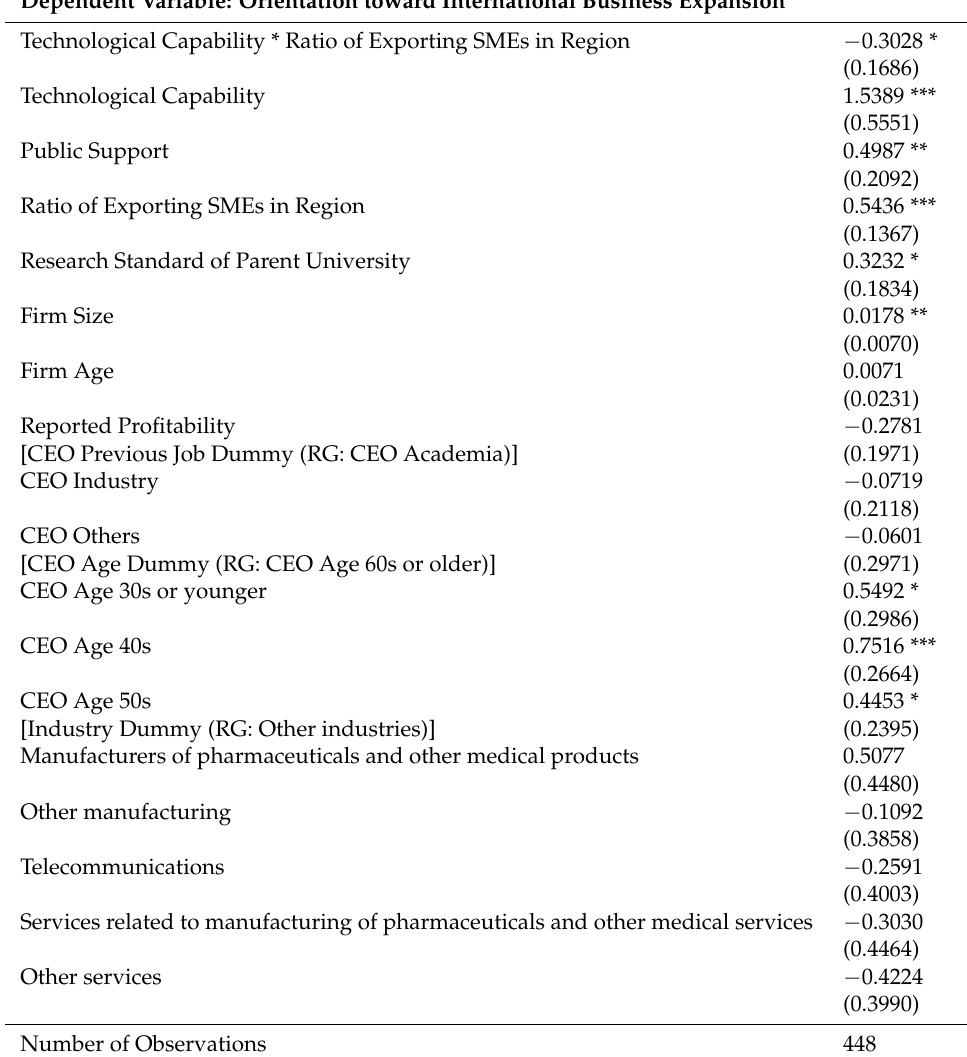
Determinants of orientation toward international business expansion: analysis of substituting